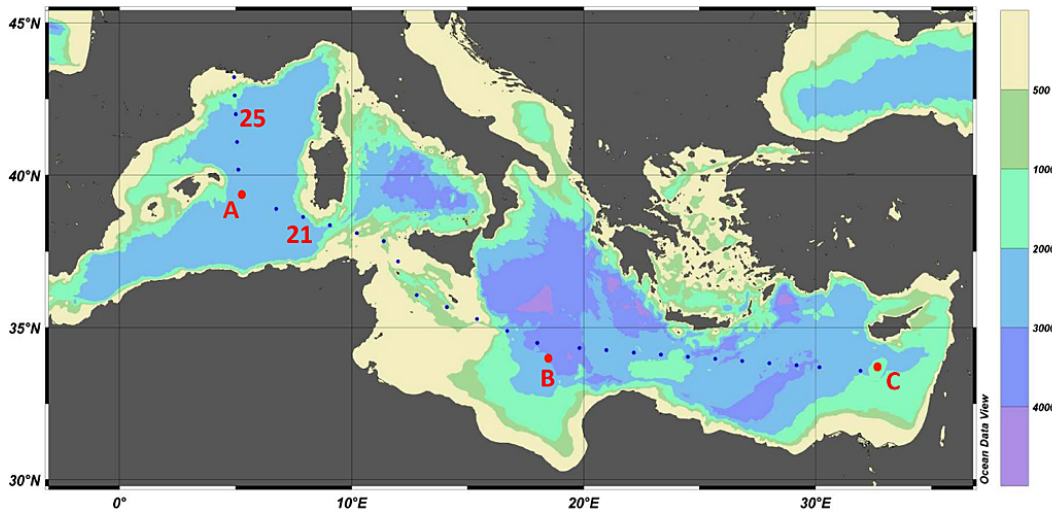
Fig. 1. Location of the BOUM transect and sampling sites: stations St. 25, A, 21, B and C from West to